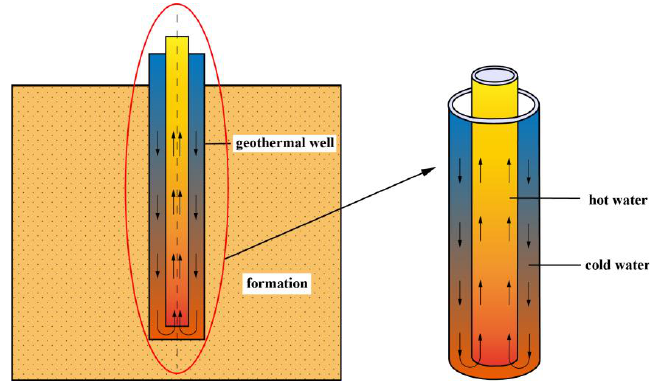
Figure 3. Schematic diagram of single-well closed-loop geothermal system.